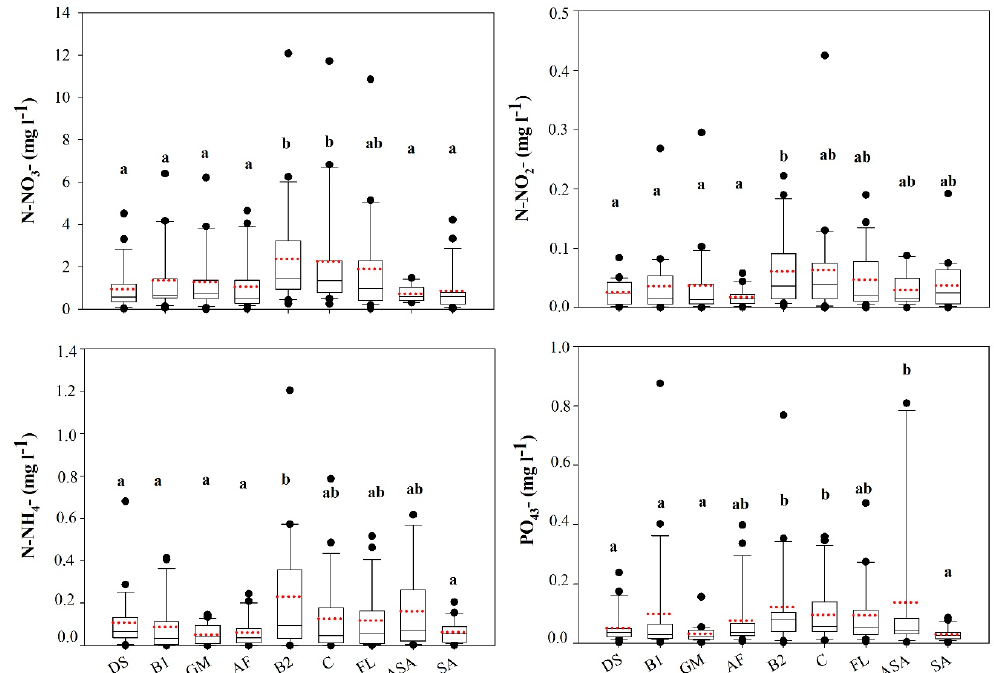
Figure 5. Nitrogen and phosphorus concentrations (mg L − 1 ) from various land uses for the period 1991–2011 (red dotted line: mean value; black line: median values; black points: outliers; borders of the box are 25 and 75 percentiles; and borders of the box plot are the 10 and 90 percentiles). DS: Dense shrub cover; B1: burned plot 1; GM: grazing meadows; AF: abandoned field; B2: burned plot 2; C: Cereal; FL: fallow land; ASA: abandoned shifting agriculture; AS: active shifting. Means with the di ff erent lower-case letter within are significantly di ff erent at the 0.05 level of significance ( p <